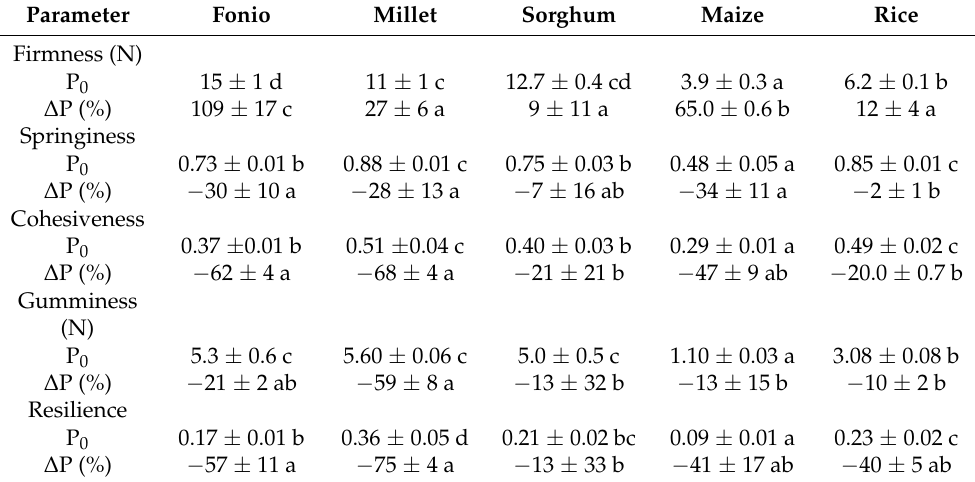
Table 6. Textural parameters of fresh gels (15% flour concentration) and their evolution with storage at 4 ◦ C for 192 h (8 days). Parameter Fonio Millet Sorghum Maize Rice Firmness (N) P 0 15 ± 1 d 11 ± 1 c 12.7 ± 0.4 cd 3.9 ± 0.3 a 6.2 ± 0.1 b ∆ P (%) 109 ± 17 c 65.0 ± 0.6 b 12 ± 4 a Springiness P 0 0.73 ± 0.01 b 0.88 ± 0.01 c Cohesiveness